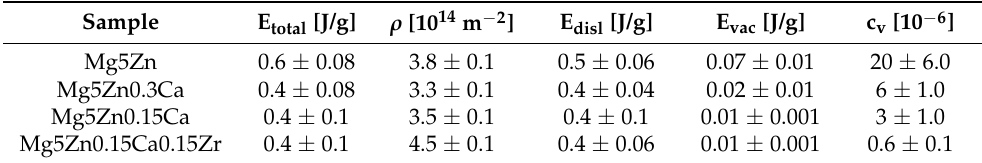
Table 6. Measured and calculated data for DSC peak II. ρ is the dislocation density (measured), E disl is the dislocations’ stored energy calculated from ρ , and c v is the vacancy concentration (calculated).